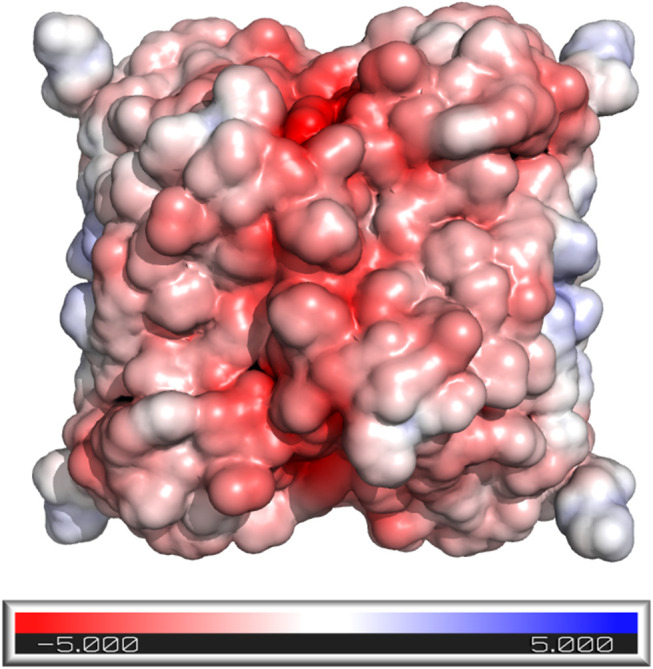
AvNRT surface colored according to the molecular electrostatic potential [ranging from −5.0 (red) to 5.0 (blue)] computed using the APBS program (Jurrus et al., 2018), as implemented in PyMOL (Delano, 2002).